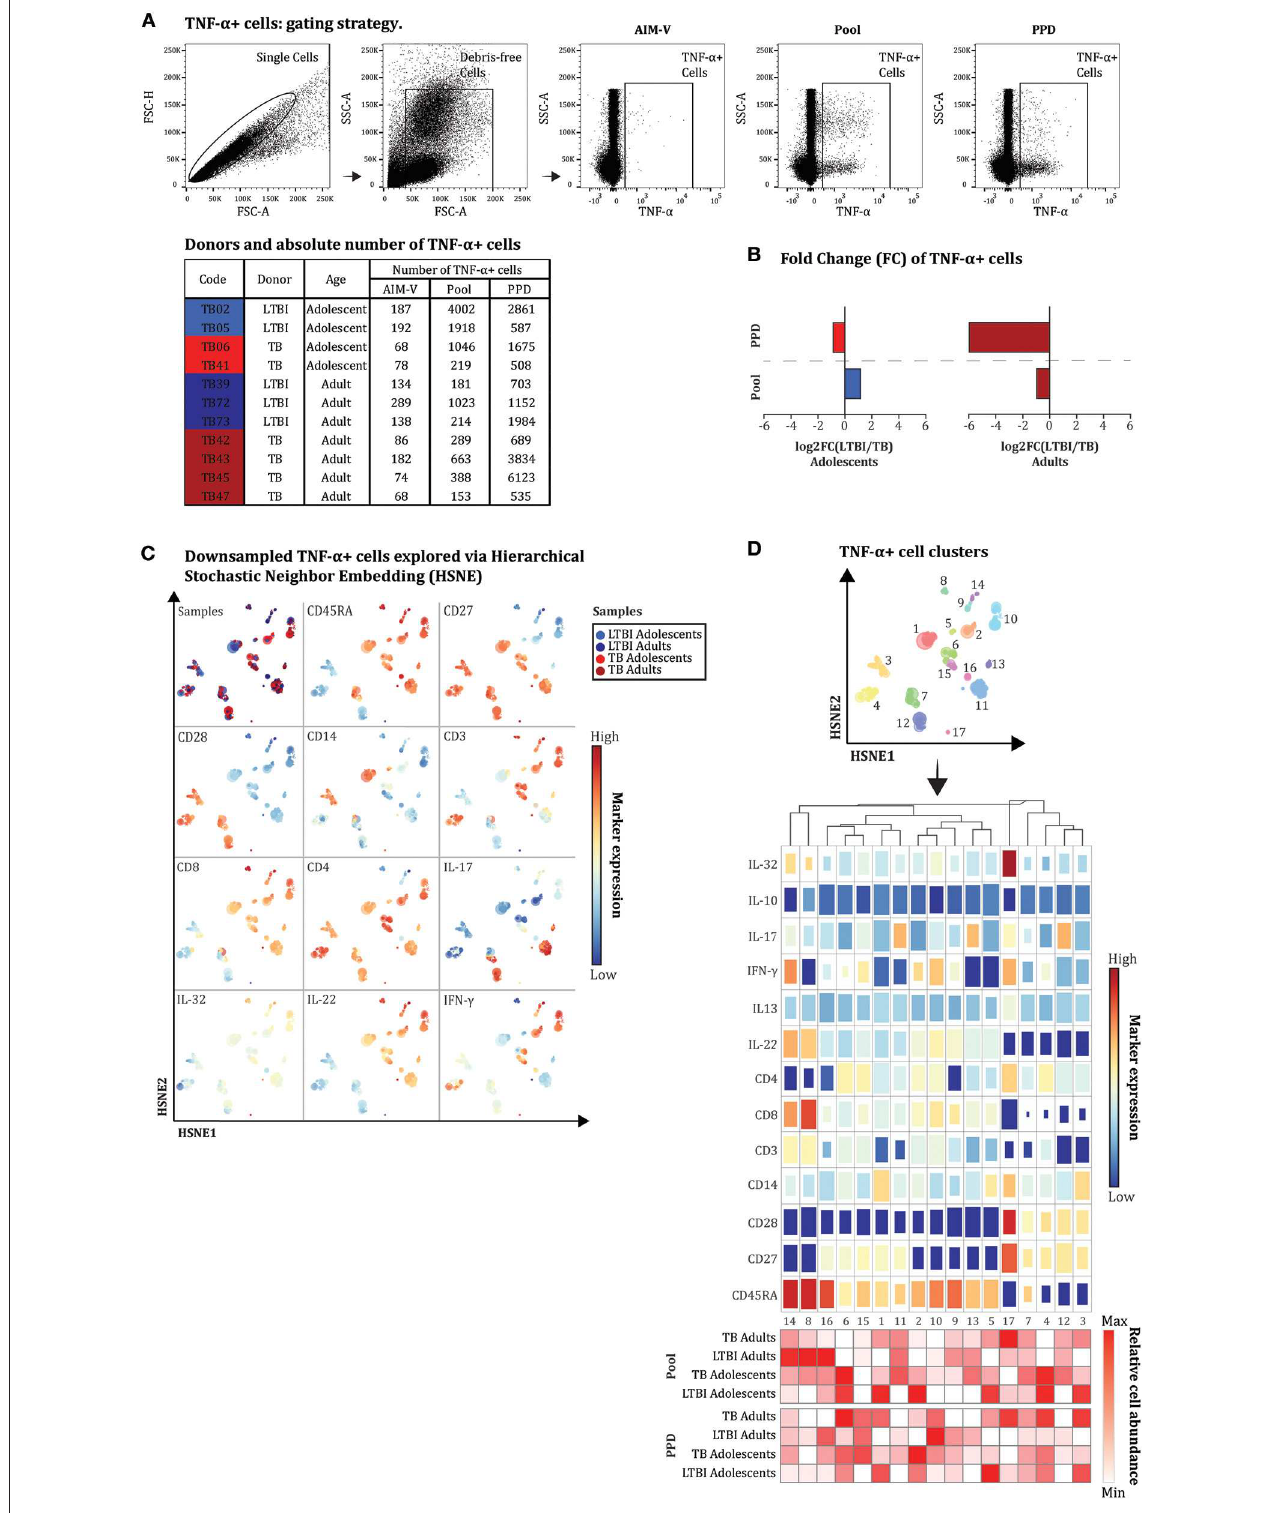
FIGURE 3 | Quantitative and qualitative differences are present in specific TNF- α + cell subsets between LTBI and TB patients. Intracellular cytokine staining was performed on whole blood (ICS-WB) of a limited number of Mtb exposed individuals recruited in this study ( n = 11). Samples were left unstimulated or stimulated